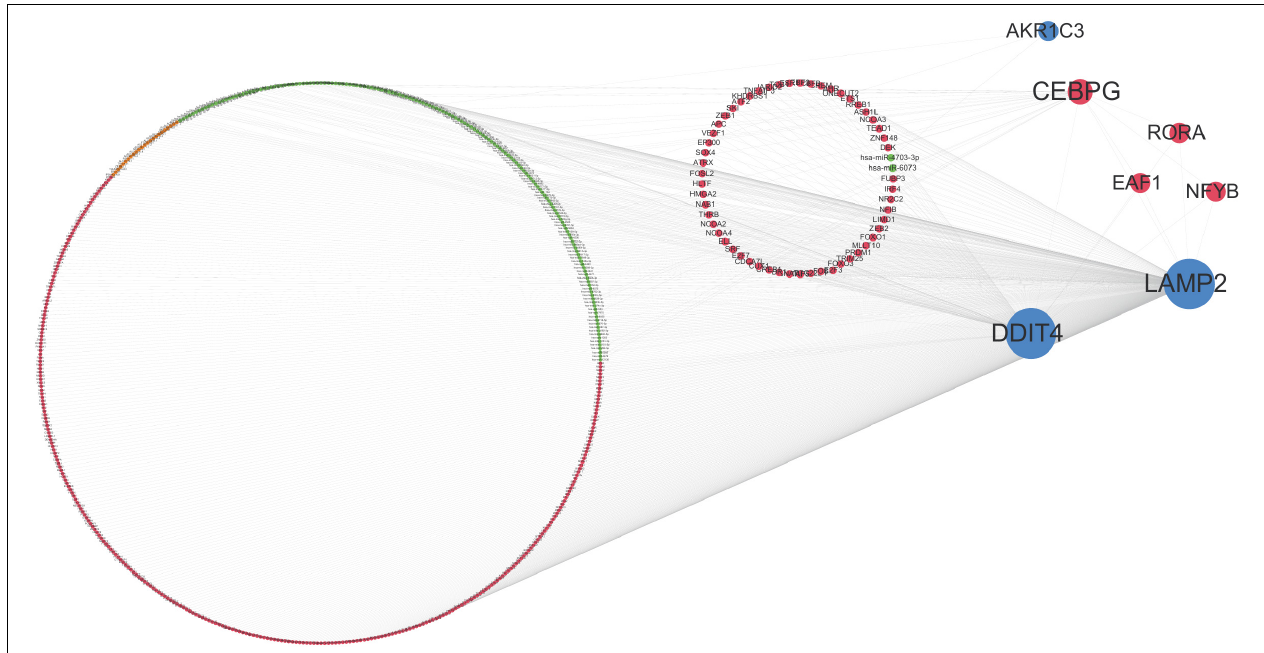
FIGURE 6 | Multi-factor regulatory network. Orange dots represent lncRNAs, red dots represent transcription factors (TF), green dots represent miRNAs, blue dots represent mRNAs, and the size of dots represents the number of regulatory genes.